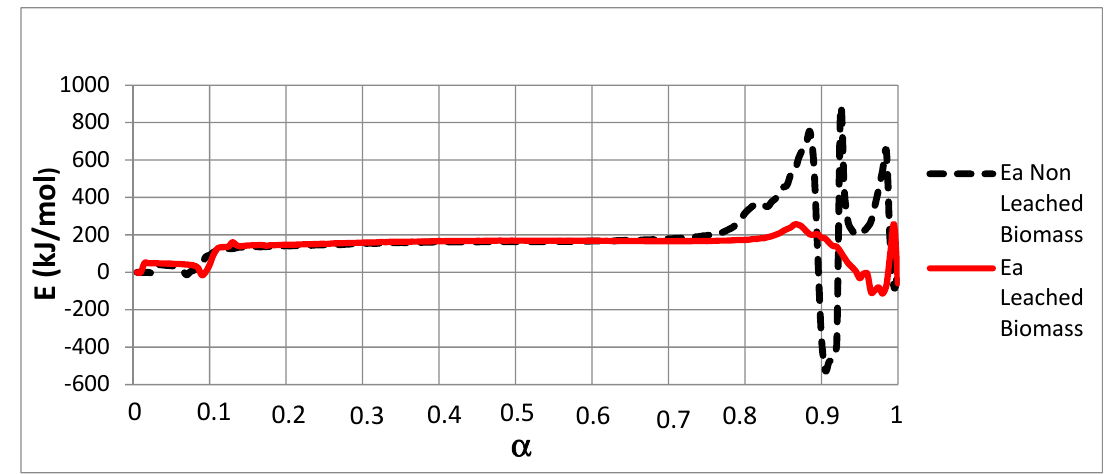
Figure 3. E versus α using the Friedman method for NL-B and L-B samples.